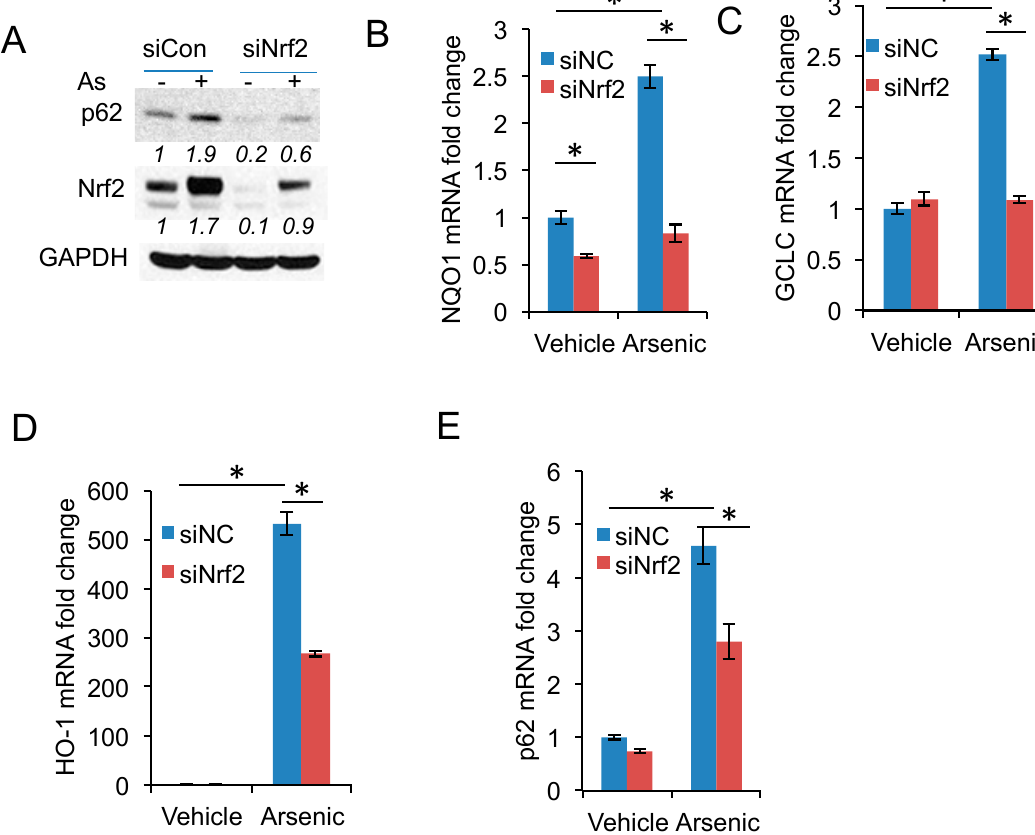
Figure 3. Nrf2 activation is required for arsenic-induced p62 expression: ( A ) Immunoblot analysis of p62, Nrf2, and GAPDH in HaCaT cells transfected with siRNA targeting negative control (siCon) or Nrf2 (siNrf2). The cells were treated with or without arsenic (8 µ M) for 6 h; ( B – E ) Real-time PCR analysis of the mRNA levels of: NQO1 ( B ); GCLC ( C ); HO-1 ( D ); and p62 ( E ) in cells as in ( A ). * p < 0.05, Student’s t -test, statistically significant between comparison groups.